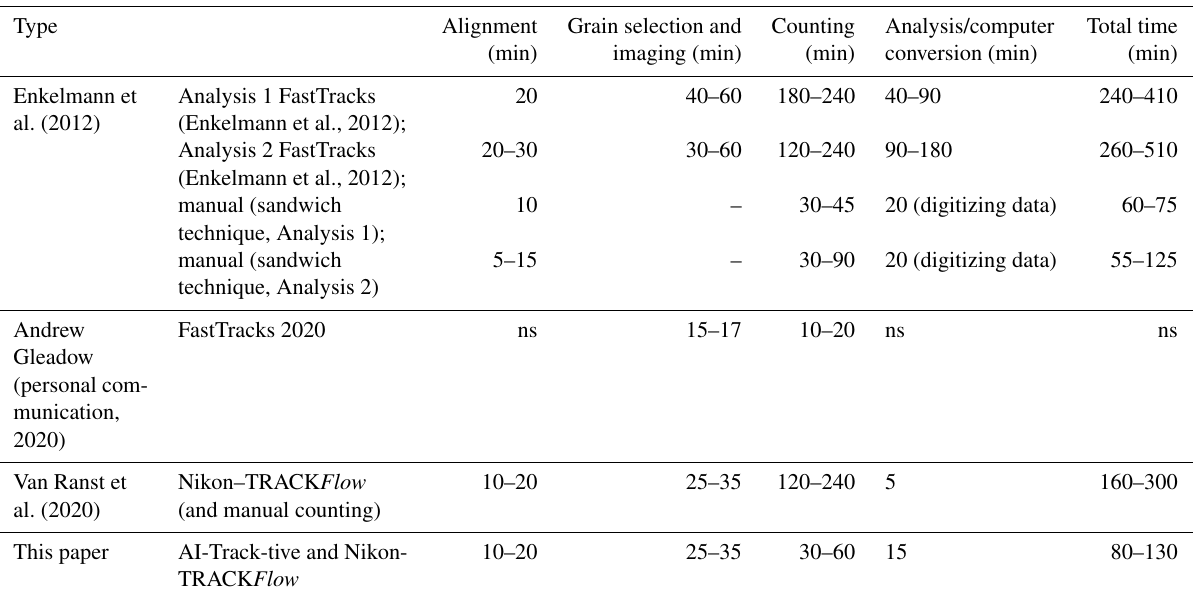
Table 3. Estimated time for 20–30 grains/polygons using different automated track recognition software packages and manual counting results from Enkelmann et al. (2012). Non-specified information is indicated using “ns”. Type Alignment Grain selection and Counting Analysis/computer Total time (min) imaging